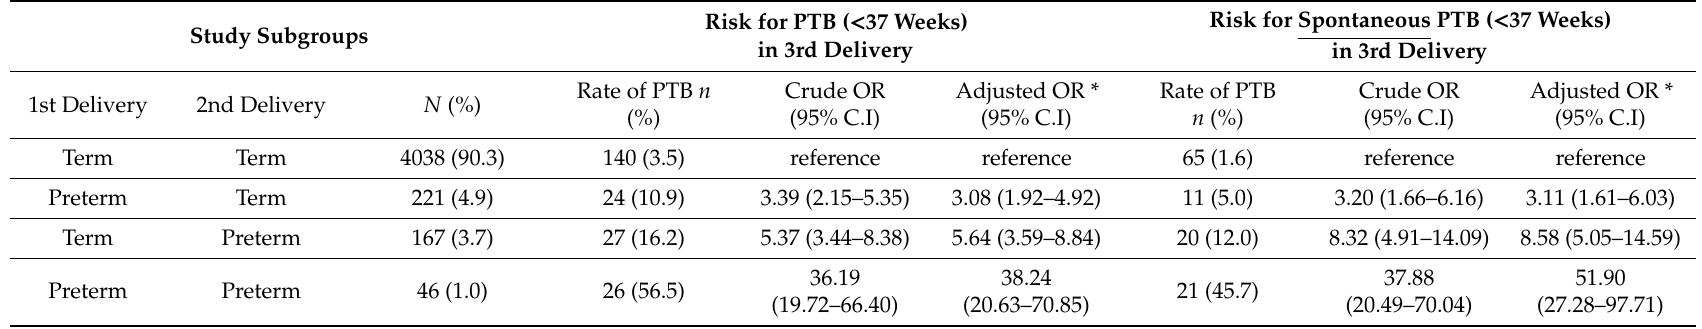
Table 2. The risk for preterm birth in the third delivery stratified by obstetrical history of preterm